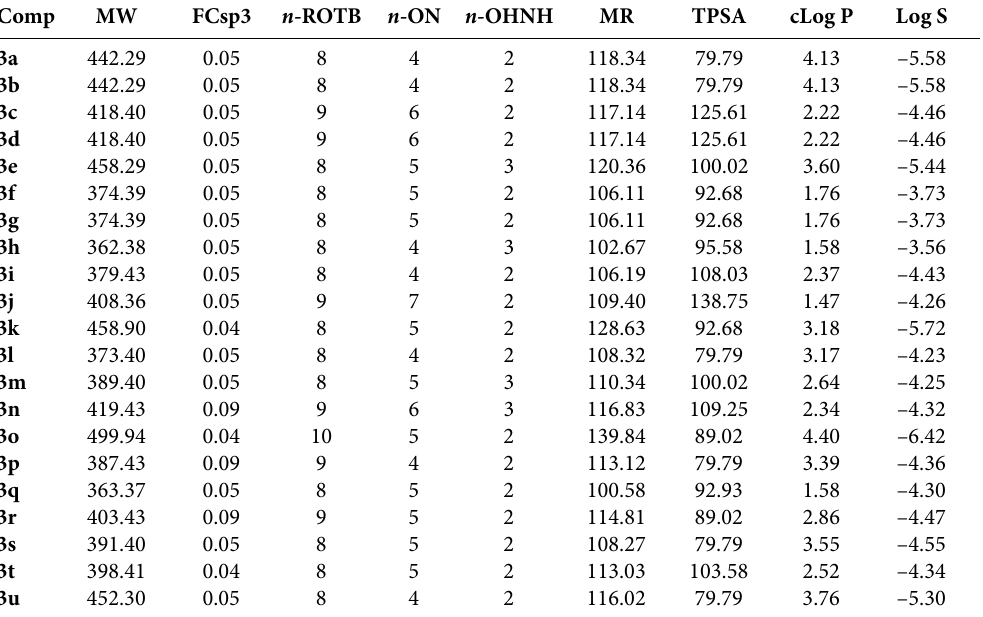
Table 2 . The physicochemical properties of hydrazone derivatives ( 3a - u ).